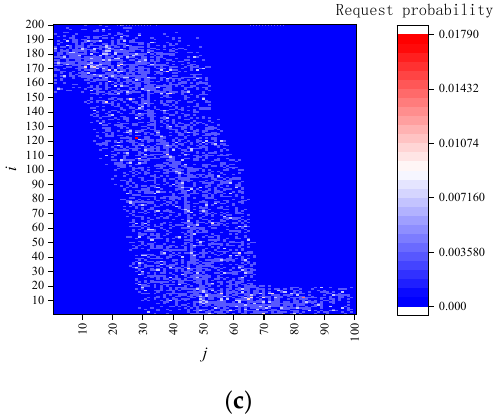
Figure 5. The probability distribution of service requests. ( a ) without location privacy preservation method; ( b ) with location privacy preservation method based on dummy locations; ( c ) with the proposed trajectory privacy preservation method.